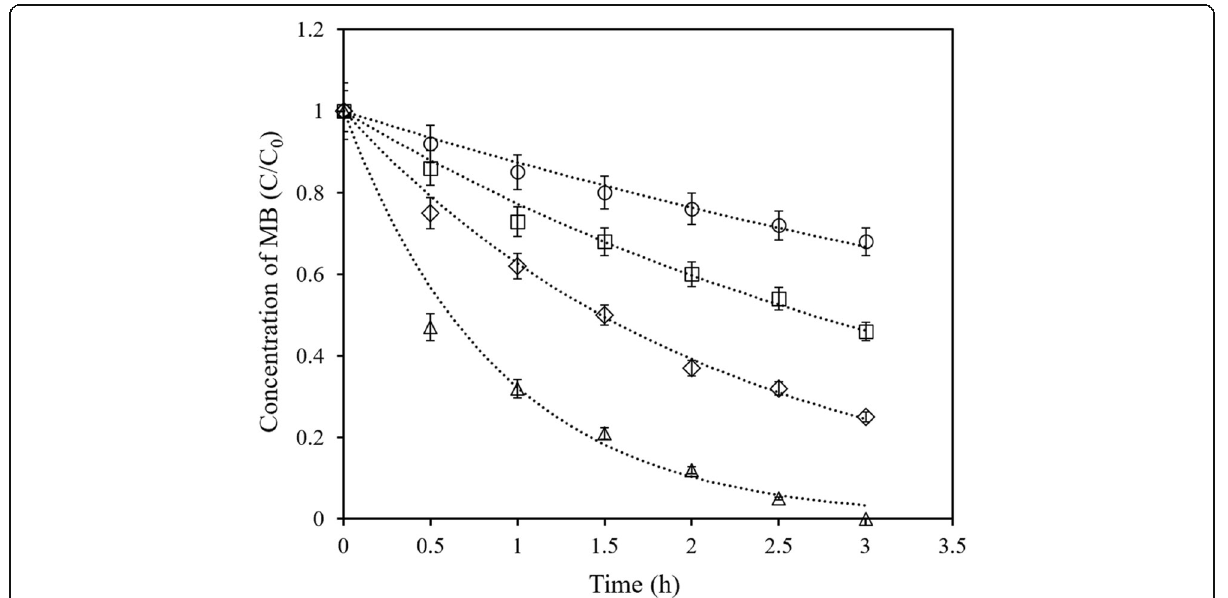
Fig. 8 Effect of initial concentration of MB on the efficiency of electrochemical degradation by using CNTs/CF M as both cathode and anode under an applied current of 50 mA and electrolyte of 0.1 M H 2 SO 4 (initial pH value of 1.83). Initial MB concentration of △ : 5 mg L − 1 ; ◇ : 10 mg L − 1 ;